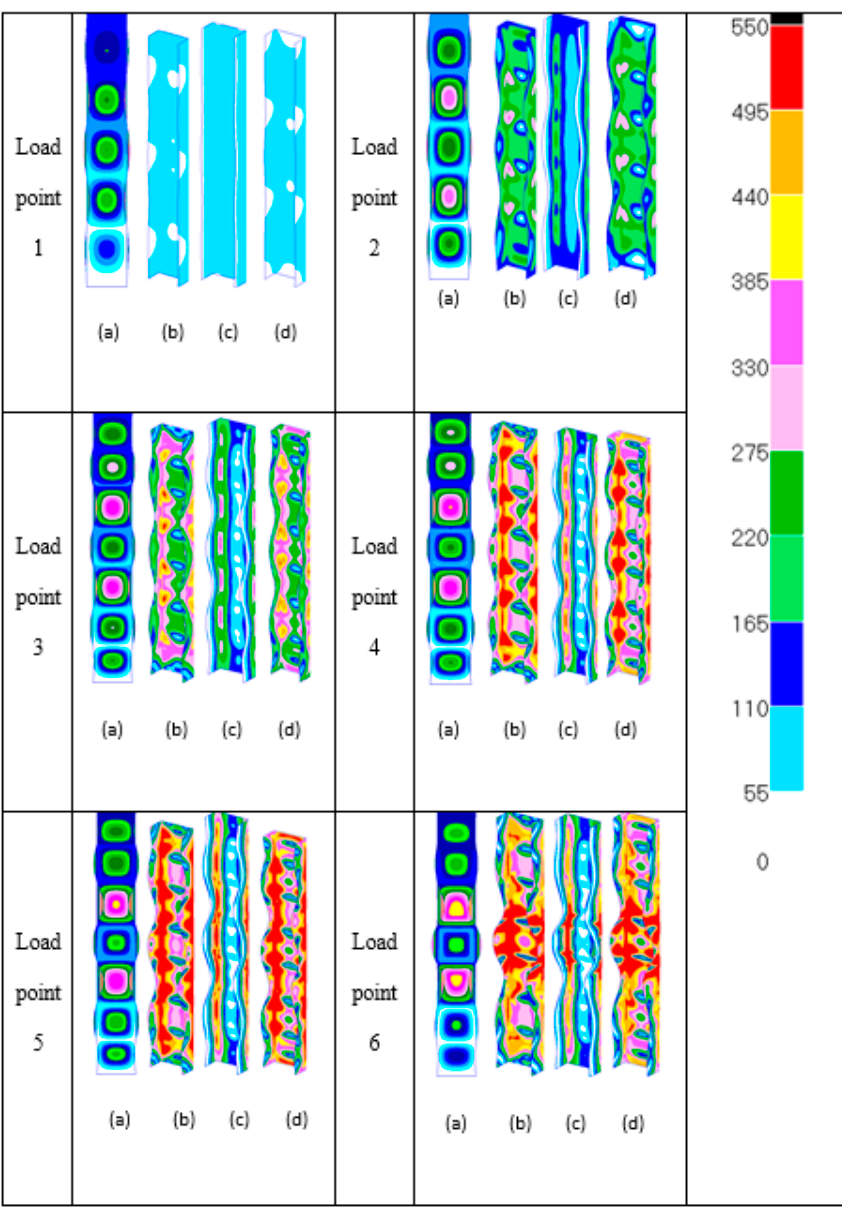
Figure 12. Deformation plots ( a ) and growth of von Mises stresses with load (( b ) outer surface 1; ( c ) middle surface; and ( d ) outer surface 2) of Figure 11 (full-model).